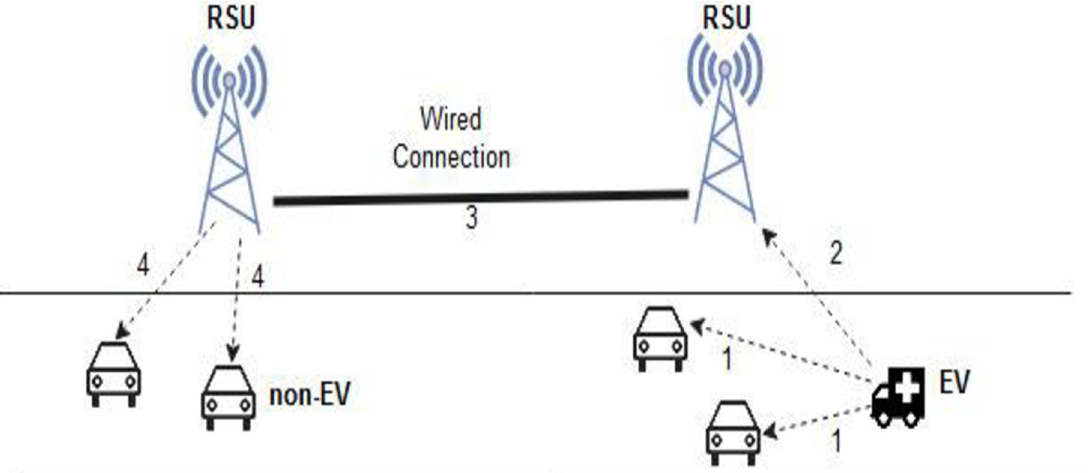
Fig 6. Message flow of the proposed approach. 1 and 2 –Direct message communication from EV to other non-Evs and the router (RSU) within its range. 3—Wired communication among the routers (RSUs). 4—Broadcasting of the message from the router (RSU) to the non- Evs.